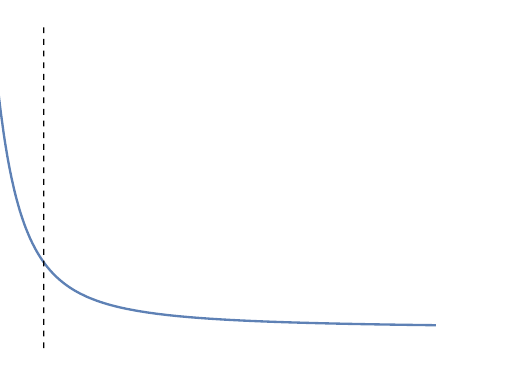
Figure 2 . A not so good starting